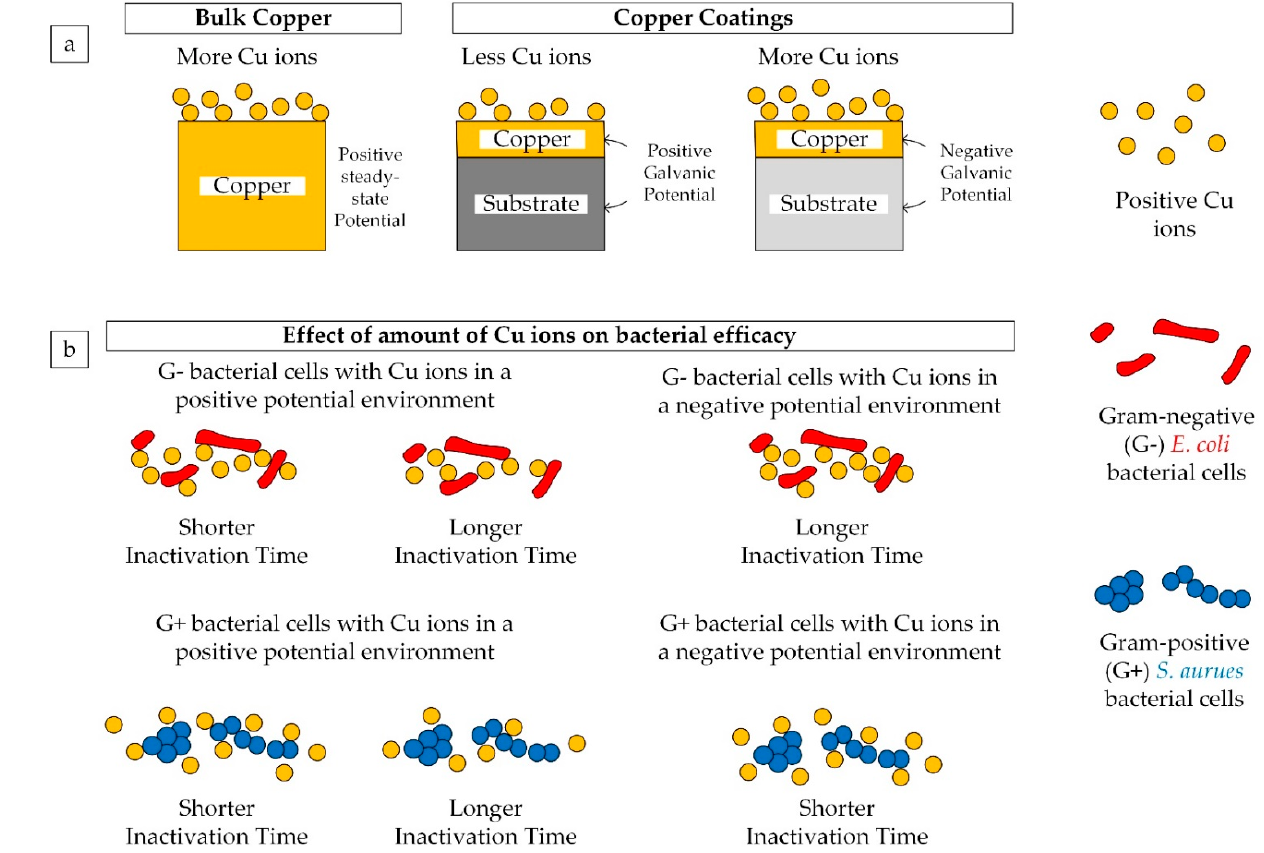
Figure 13. ( a ) Effect of the form of copper and copper/substrate on the amount of Cu ions, and ( b ) Effect of amount of Cu ions on bacterial efficacy.